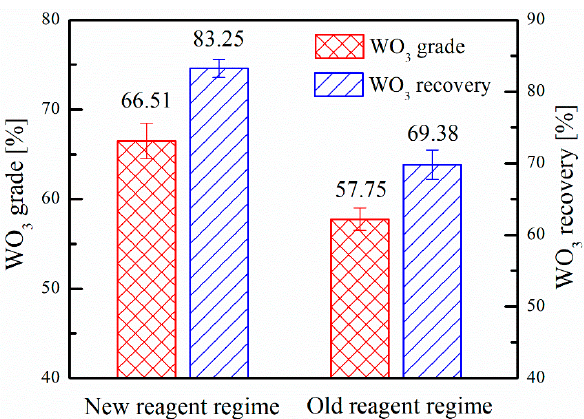
Figure 4. Closed-circuit experiment results of scheelite heating flotation using the new and old reagent